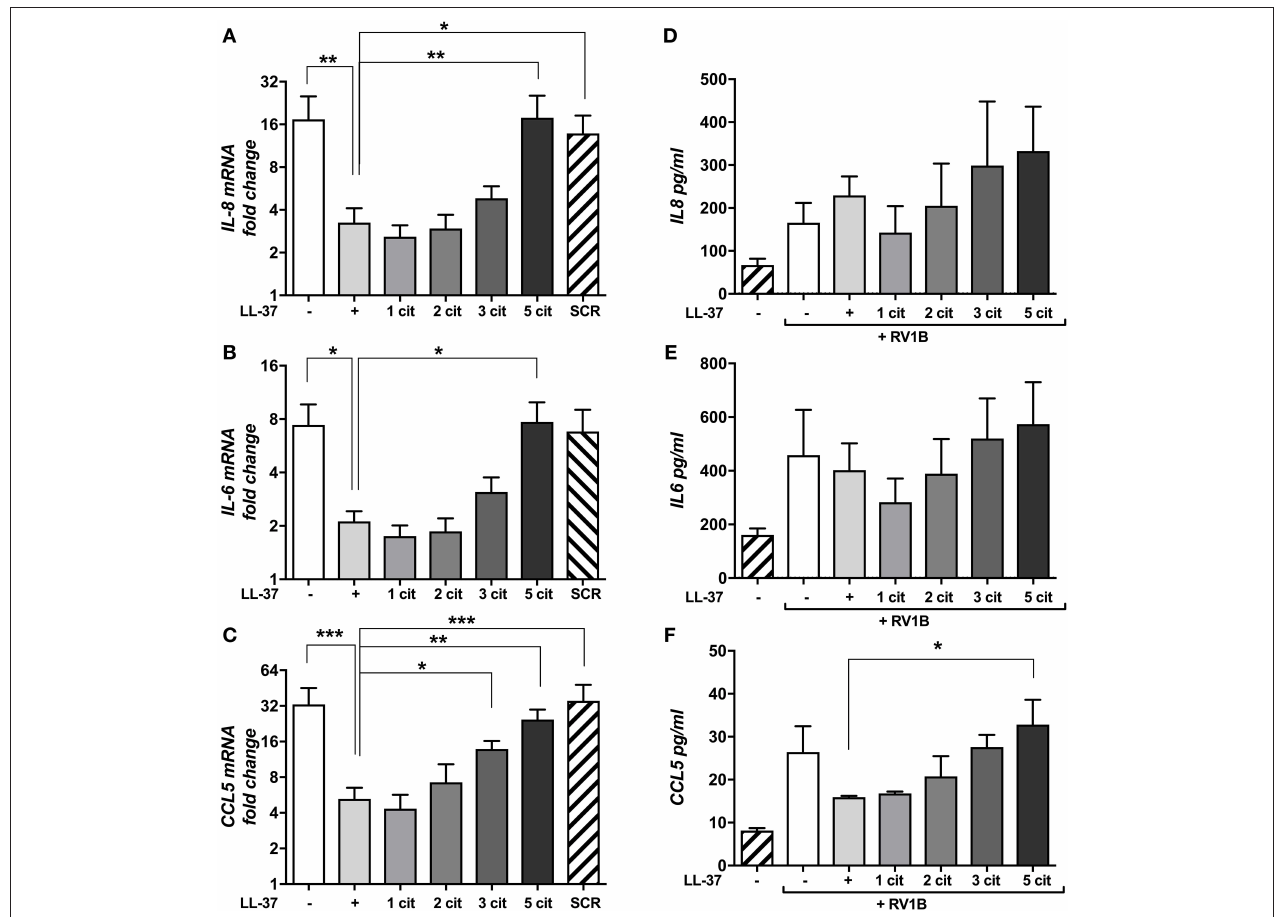
FIGURE 2 | Citrullination of LL-37 modulates cytokine expression and secretion induced by human rhinovirus. Purified HRV1B viral particles were pre-treated with 30 µ g (A–C) or 10 µ g (D–F) of native or differentially citrullinated LL-37 peptides for 2h and incubated with 16HBE14 ◦ − cells for 1h at a final MOI of 1. Cells were washed to remove inoculum and left 24h before RNA extraction. Levels of IL-8 (A) , IL-6 (B) , and CCL5 (C) mRNA transcripts were addressed by qPCR. Values represent fold-changes over uninfected cells. Protein concentrations of IL-8 (D) , IL-6 (E) , and CCL5 (F) released into cell supernatants were assessed by ELISA. Data represent mean values ± SEM for n = 3 experiments for each condition. * p ≤ 0.05, ** p ≤ 0.01, *** p ≤ 0.001. Statistical analysis performed by one-way ANOVA with Dunnet multiple comparisons test.